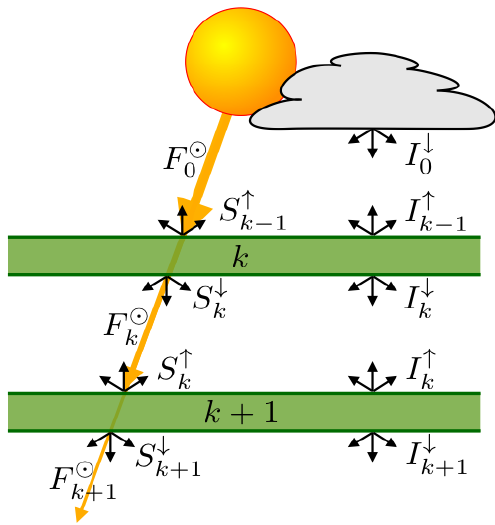
Figure B1. Propagation of solar radiation through canopy layers. Each layer k is comprised of one or more cohorts according to the PPA model. I ↑ and I ↓ are the upward and downward fluxes of dif- fuse radiation, F (cid:12) is direct solar beam radiation flux, and S ↑ and S ↓ are upward and downward diffuse radiation fluxes due to canopy scattering of direct beam